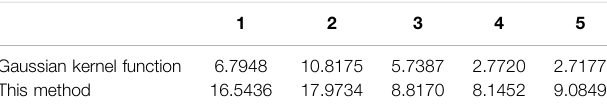
Frontiers in Bioengineering and Biotechnology |